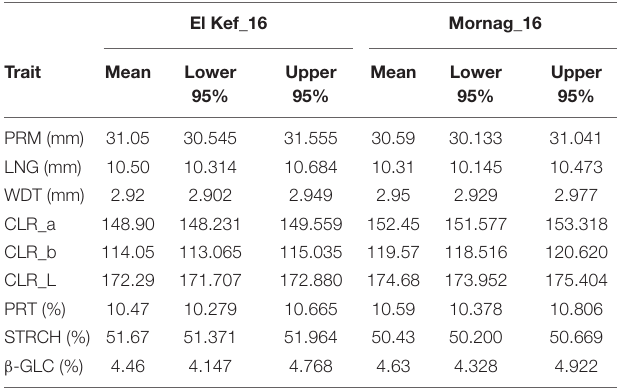
TABLE 8 | Grain quality parameters means and confidence intervals of barley entries evaluated in different environments in